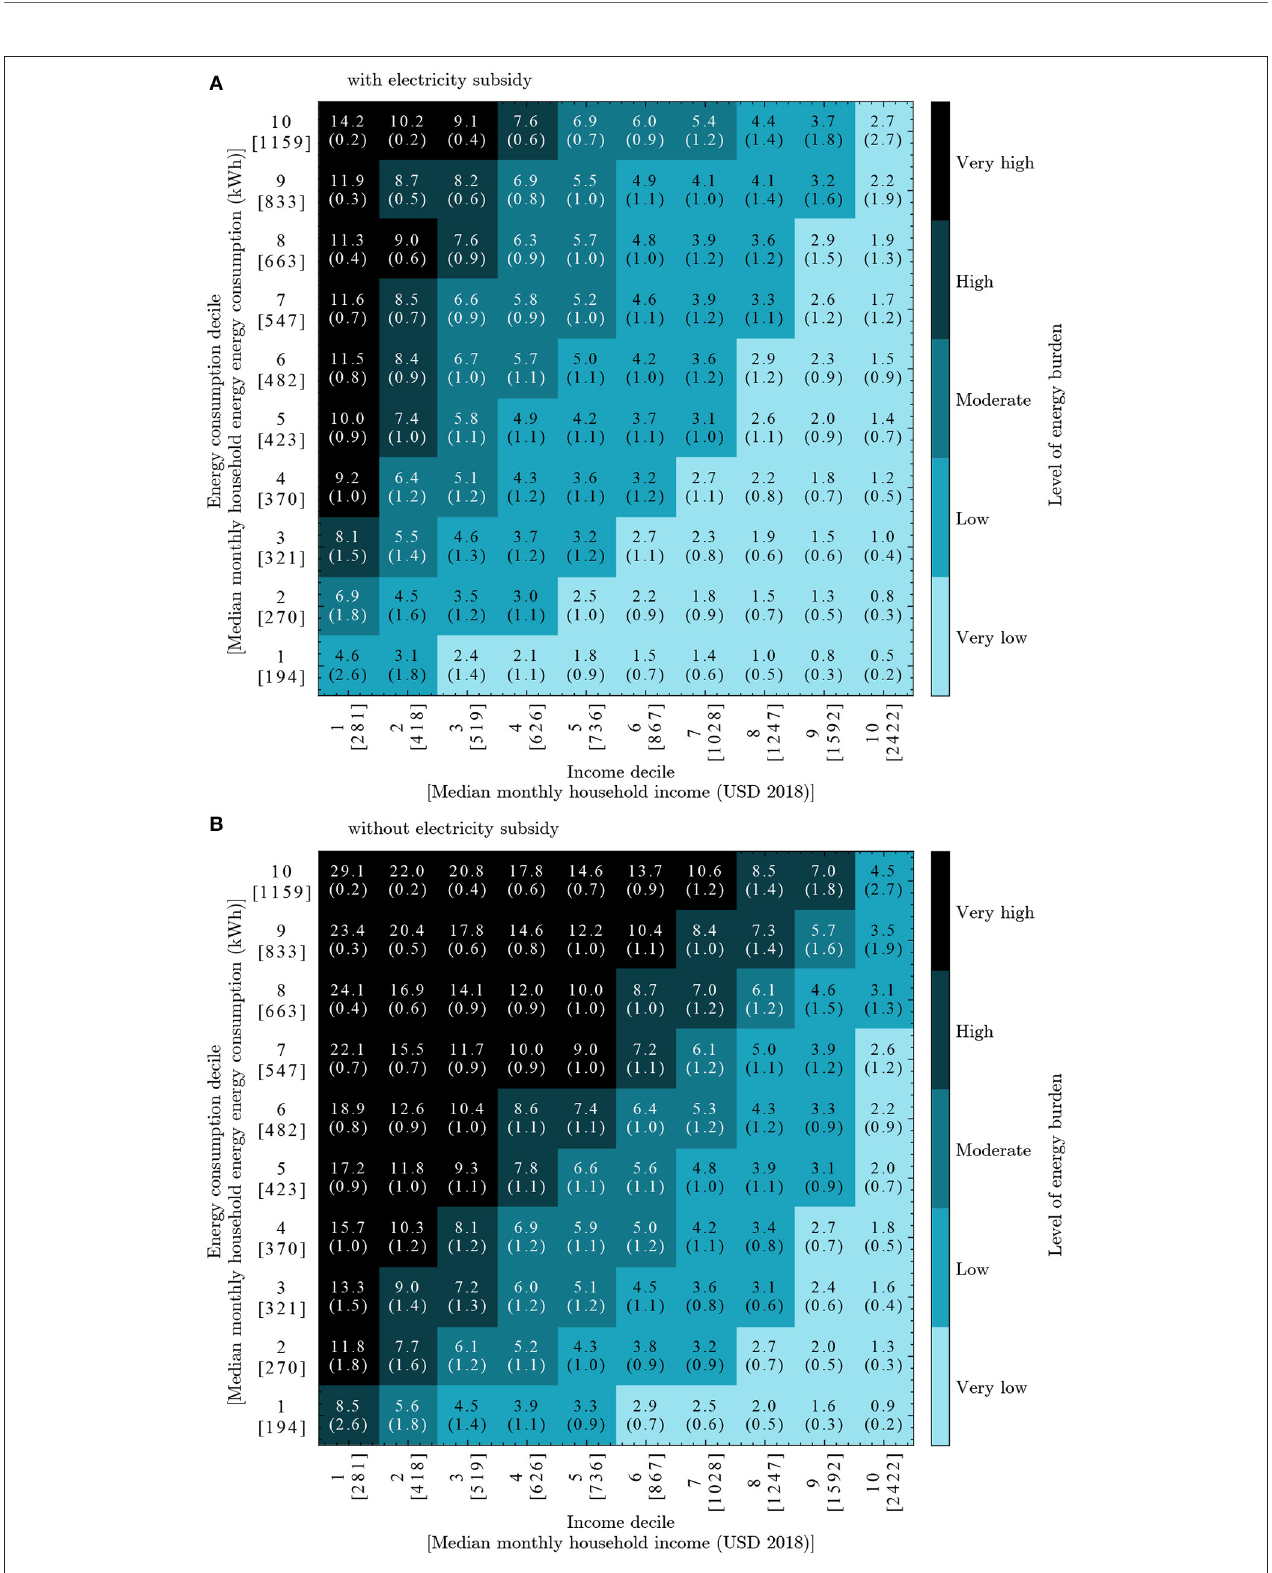
FIGURE 8 | Distribution of energy burdens of Mexican urban households by income and energy consumption decile. Energy burden values and share of population (in parentheses) are displayed as percentages inside each cell. Median absolute values for each decile are shown in brackets for both axes. (A) with electricity subsidy. (B) without electricity